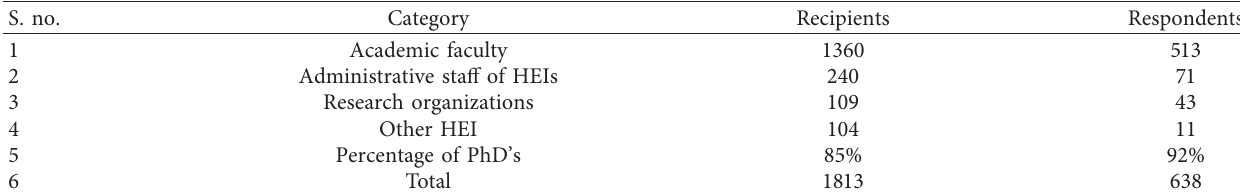
Table 4: Demographics of recipients and respondents.